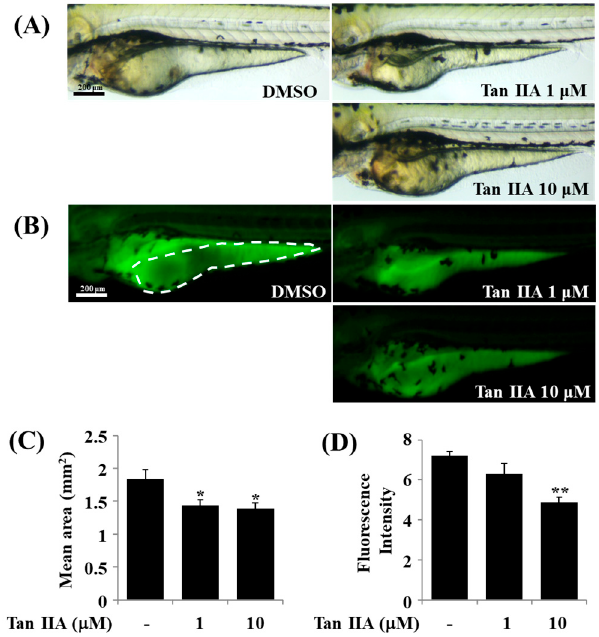
Figure 6. Effect of tanshinone IIA on lipid accumulation in zebrafish. Two day post fertilization (dpf) larvae were exposed in the absence (DMSO) or presence of tanshinone IIA at the indicated concentrations. After 24 h, three dpf larvae were stained with LipidGreen2 and visualized under bright field ( A ) and fluorescence field ( B ); ( C , D ) Size and intensity of yolk (white dash in B) were quantified using the ImageJ software, respectively. Graph bars indicate mean ± SEM (standard error of the mean). Unpaired t -test was used to analyze difference versus DMSO group, and statistical significance was set 0.05 and 0.01 (* p ≤ 0.05, ** p ≤ 0.01). n = 10.